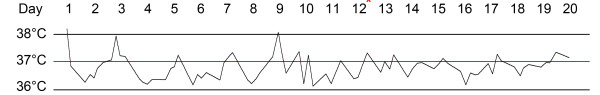
The infant’s body temperature. Shown here is an intermittent fever pattern prior to the initiation of CQ treatment on the 12th day anti-malarial(shown as an asterisk) and subsequent resolution of the fever.